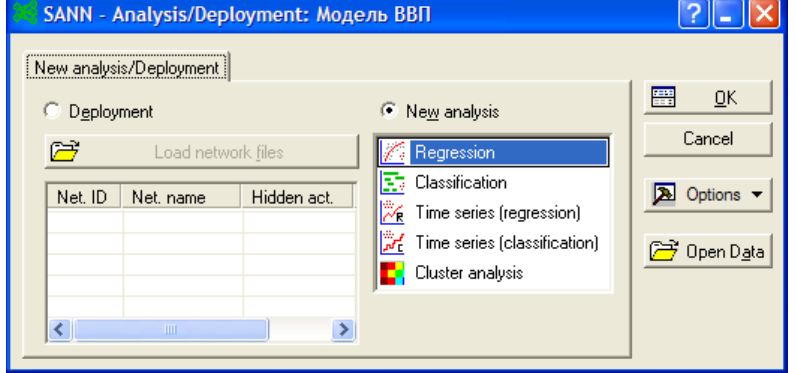
Fig. 2. Selection of data sets for the network training